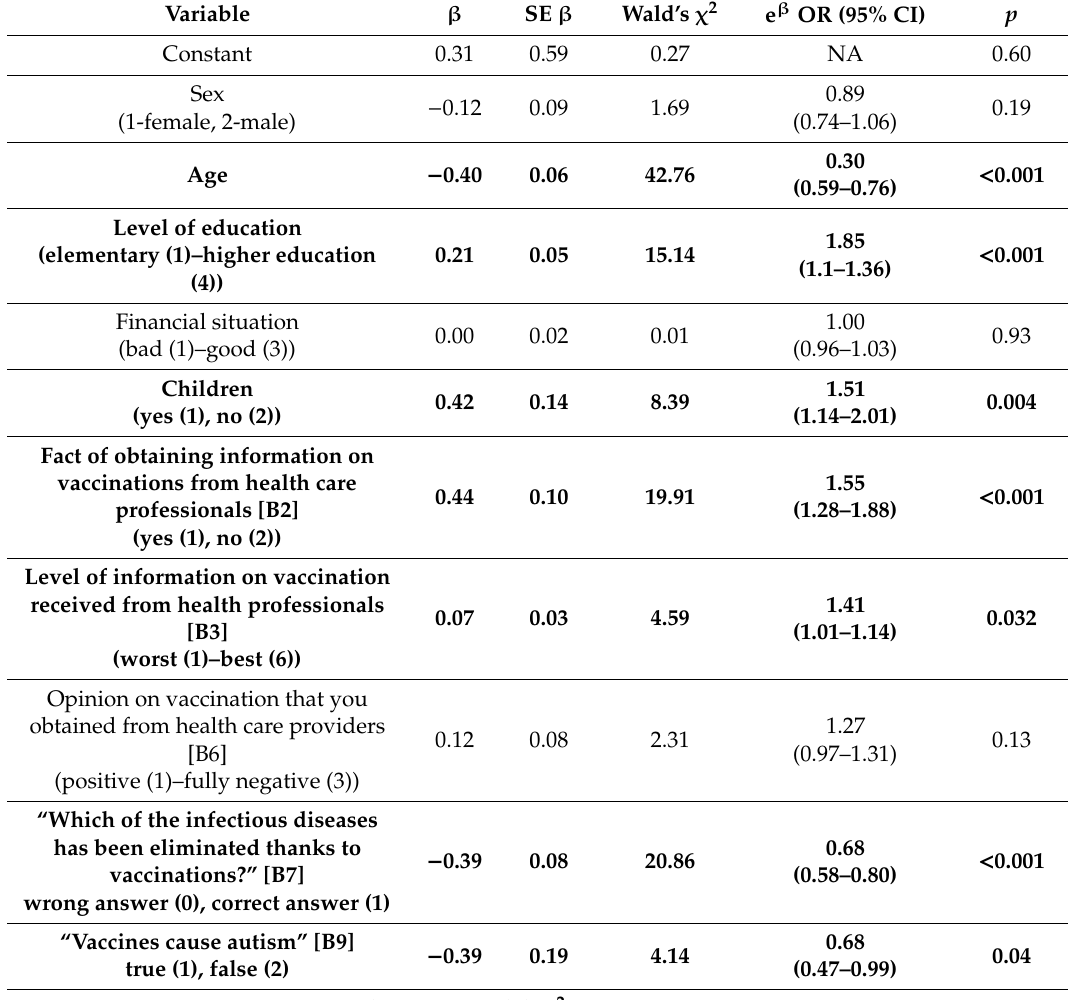
Figure 8. Mean rank-answers to B12: “Have you been vaccinated against influenza?” (YES = 1, NO = 2) in di ff erent demographical categories. ( A ) age groups, ( B ) education level groups, ( C ) groups on the basis of the fact of having children Table 4. Logistic regression model parameters and odds ratios-dependent variable: answer to the question B12 “Are you vaccinated against seasonal influenza?” (1-YES, 2-NO). Bold values denote statistical significance at the p < 0.05